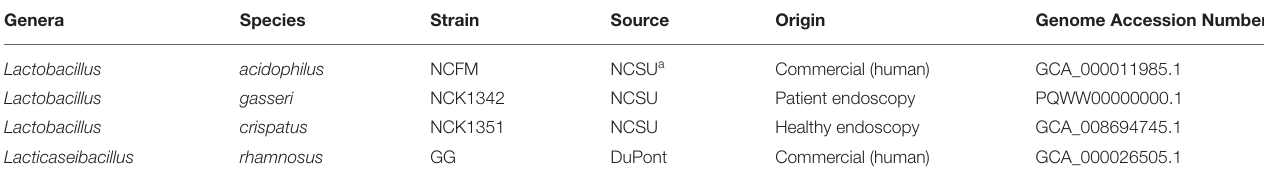
TABLE 1 | Strains used in this study: information regarding Lactobacillus strain type, origin, and accession number.